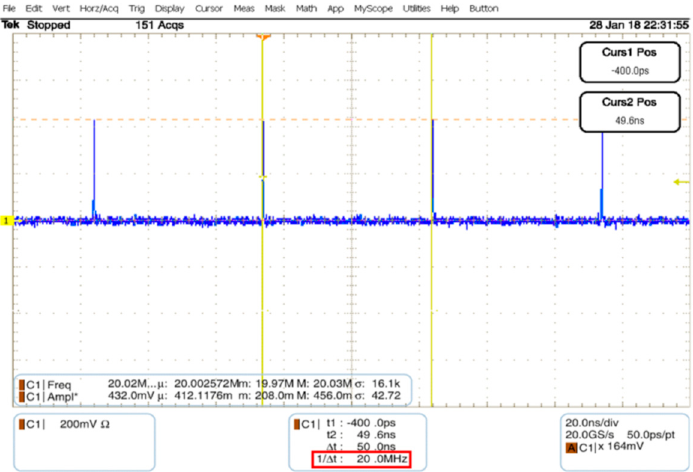
Figure 14. IR-UWB pulse generated by the FPGA scheme with pulse repetition frequency of 20 MHz using digital oscilloscope.